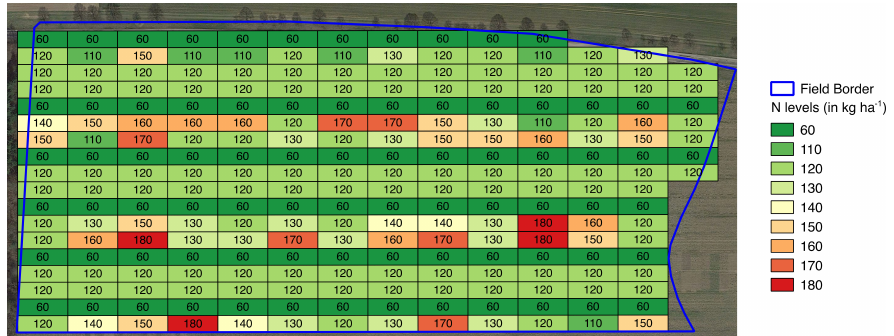
Figure 2. The colored plots reflect the different N levels for site-years 2 and 3, as shown in the legend. Each plot has a size of 36 x 12 meter (LxW).